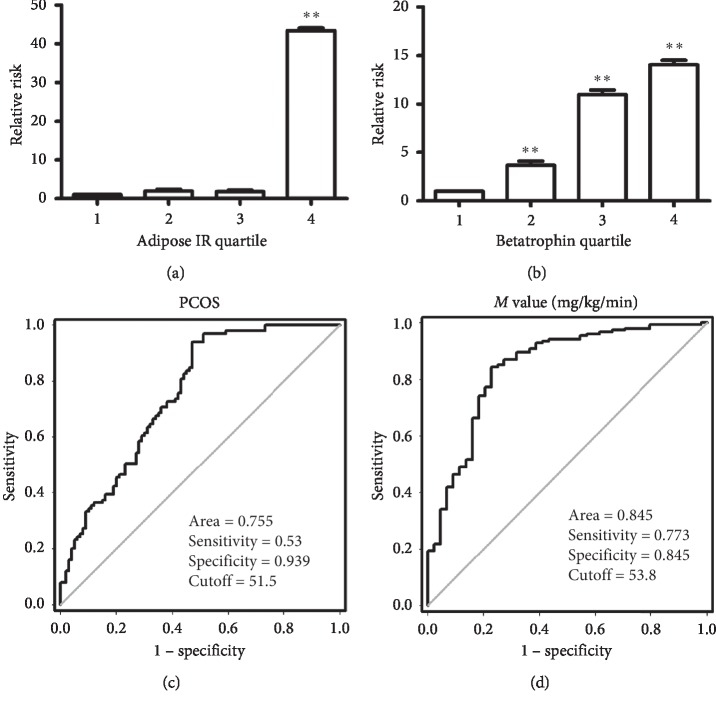
Adipose IR levels and ROC curve analysis in study population (a) Prevalence of elevated PCOS in different quartiles of adipose IR : Q1, <21.86; Q2, 21.86–33.62; Q3, 33.62–63.42; and Q4, >63.42 (vs. Q1: ∗∗p < 0.01. (b) Prevalence of elevated adipose IR in different quartiles of betatrophin: Q1, <0.30 μg/L; Q2, 0.30–0.44 μg/L; Q3, 0.44–0.62 μg/L; and Q4, >0.62 μg/L (vs. Q1: ∗∗p < 0.01). (c) ROC curve analyses for the prediction of PCOS according to the adipose IR levels. (d) ROC curve analyses for the prediction of IR (M values) according to the adipose IR levels.